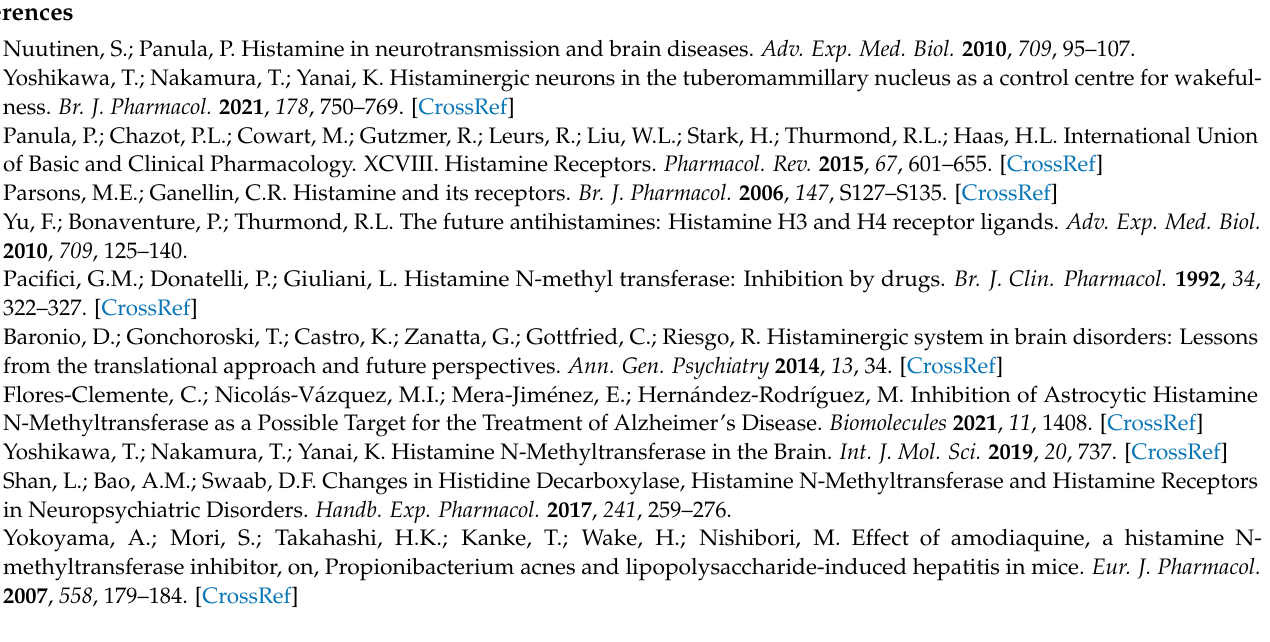
Table S1: FDA-approved drugs selected for this study which are used to treat neurological